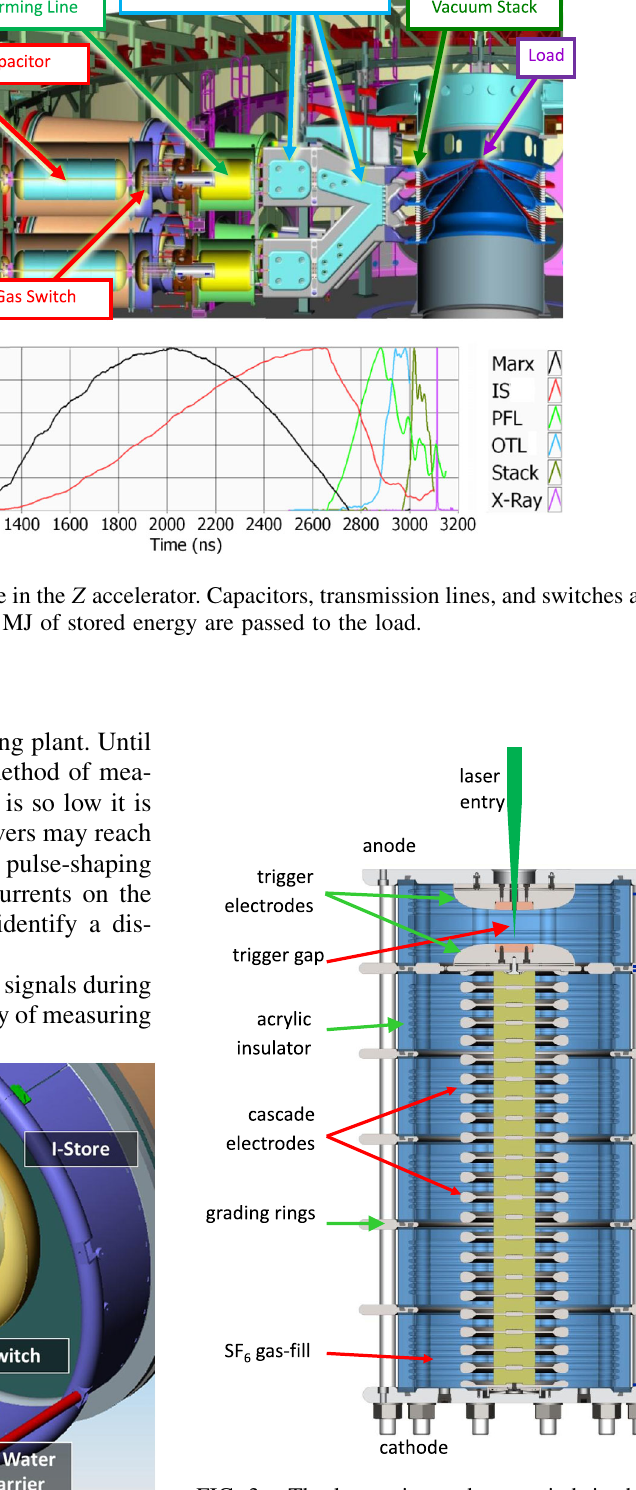
FIG. 3. The laser triggered gas switch in the Z accelerator is filled with 70 psia of SF 6 and consists of a laser ‘‘trigger section’’ and a ‘‘cascade section.’’ The laser induced breakdown of the trigger section causes an overvoltage on the cascade section and starts the self-breakdown process along the cascade electrodes which takes about 40–50 ns to